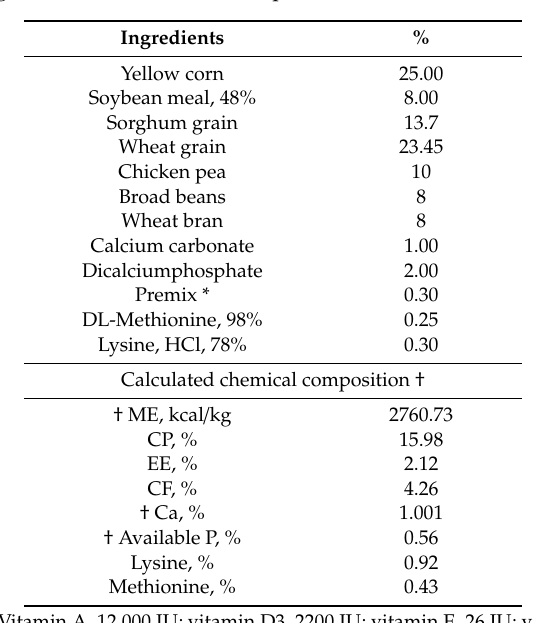
Table 1. Ingredients and chemical composition of the basal diet (as-fed